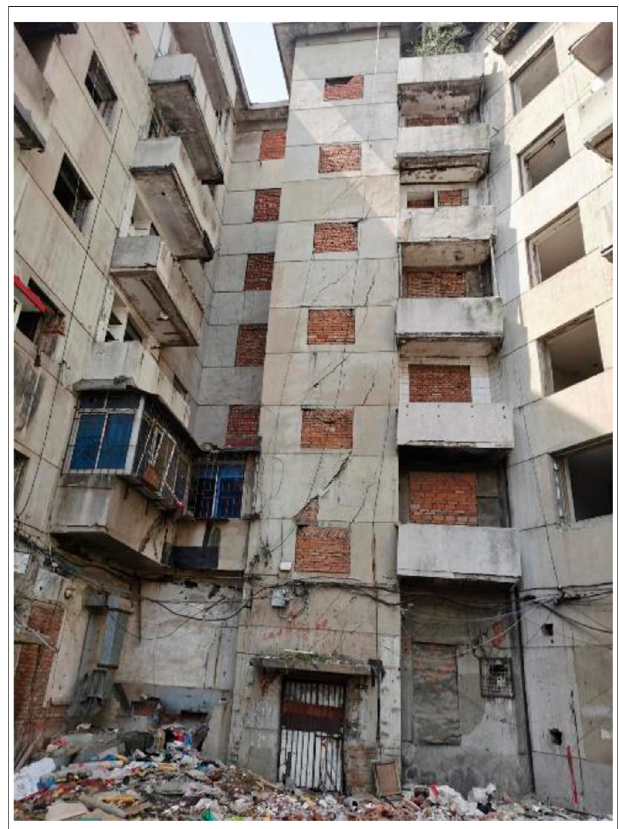
FIGURE 7 | Cracking of building wall and damage of balcony in feature- 2 area.